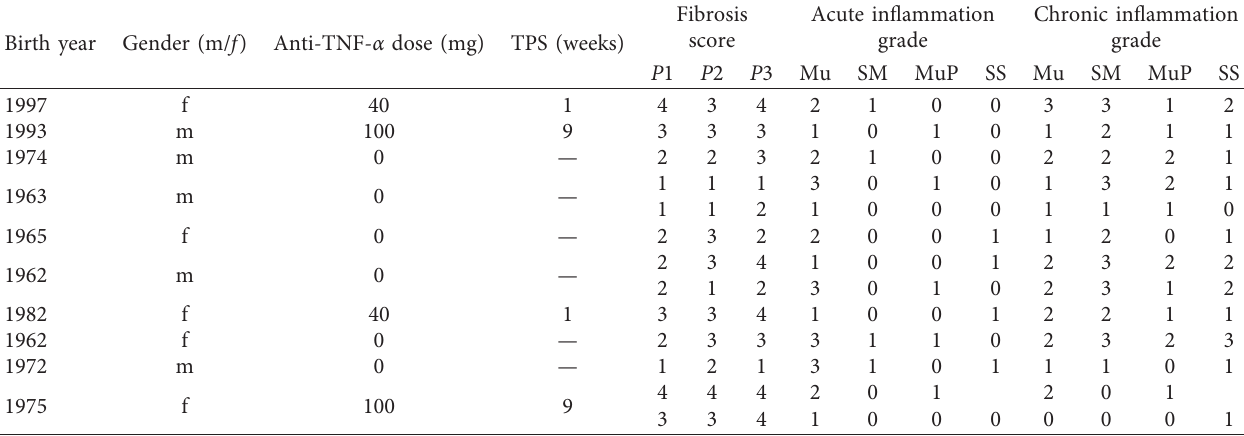
Table 2: Drug administration, fibrosis score, and inflammation grade of patients with Crohn’s